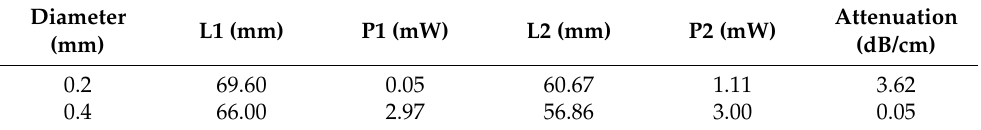
Table 4. Attenuation calculated to HDglass cores without cladding. The attenuation was measured at 650 nm wavelength region.